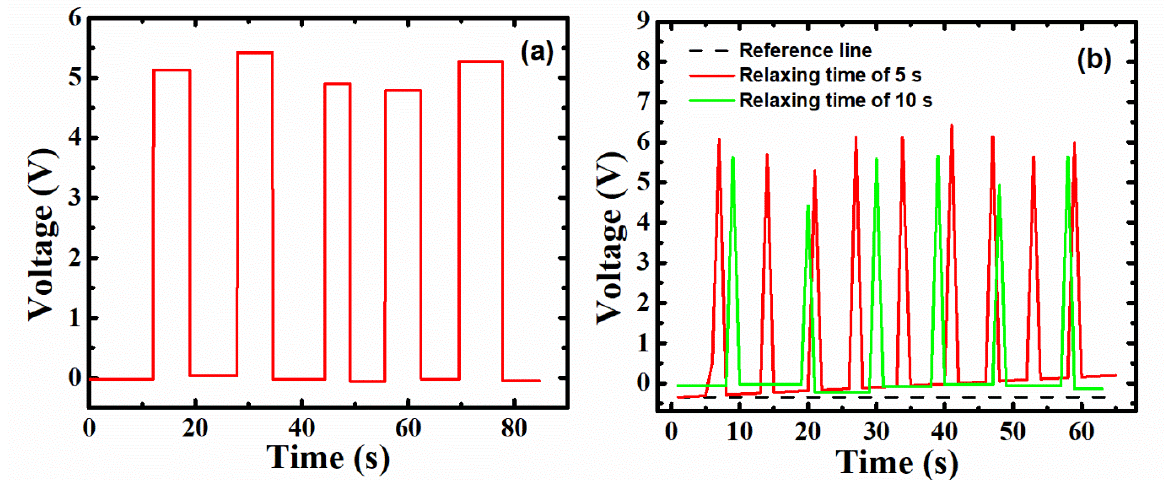
Figure 6. ( a ) Measured voltage for ≈90 s for loading and unloading 10 g, and ( b ) voltage is measured for ≈65 s with a relaxing period of ≈5 s and ≈10 s. Table 1. Comparison of output voltage produced in ZnO/PVDF hybrid flexible nanogenerator.